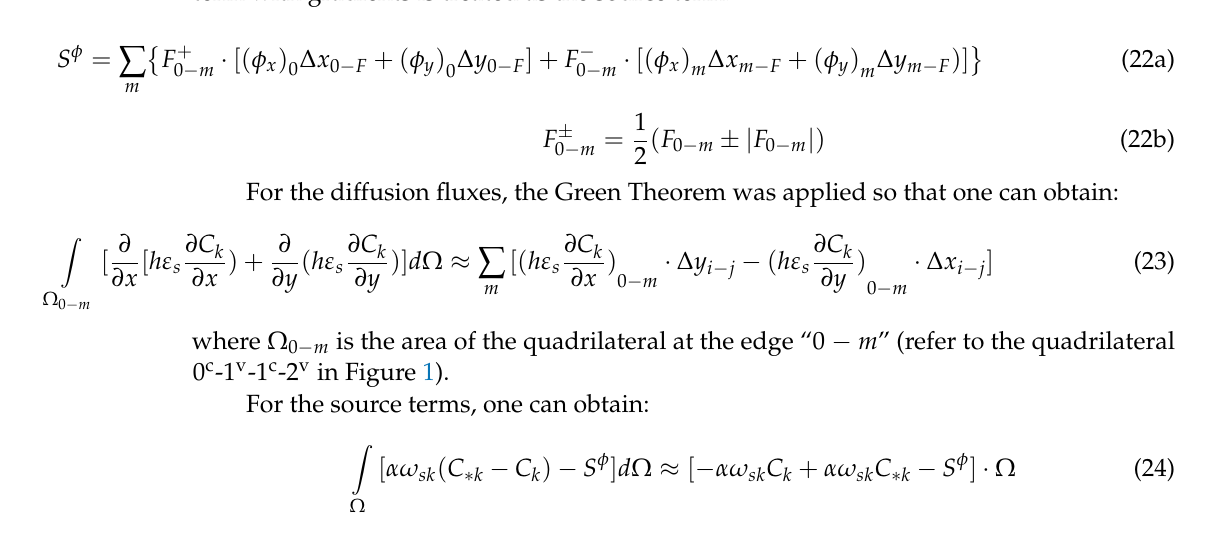
term with gradients is treated as the source